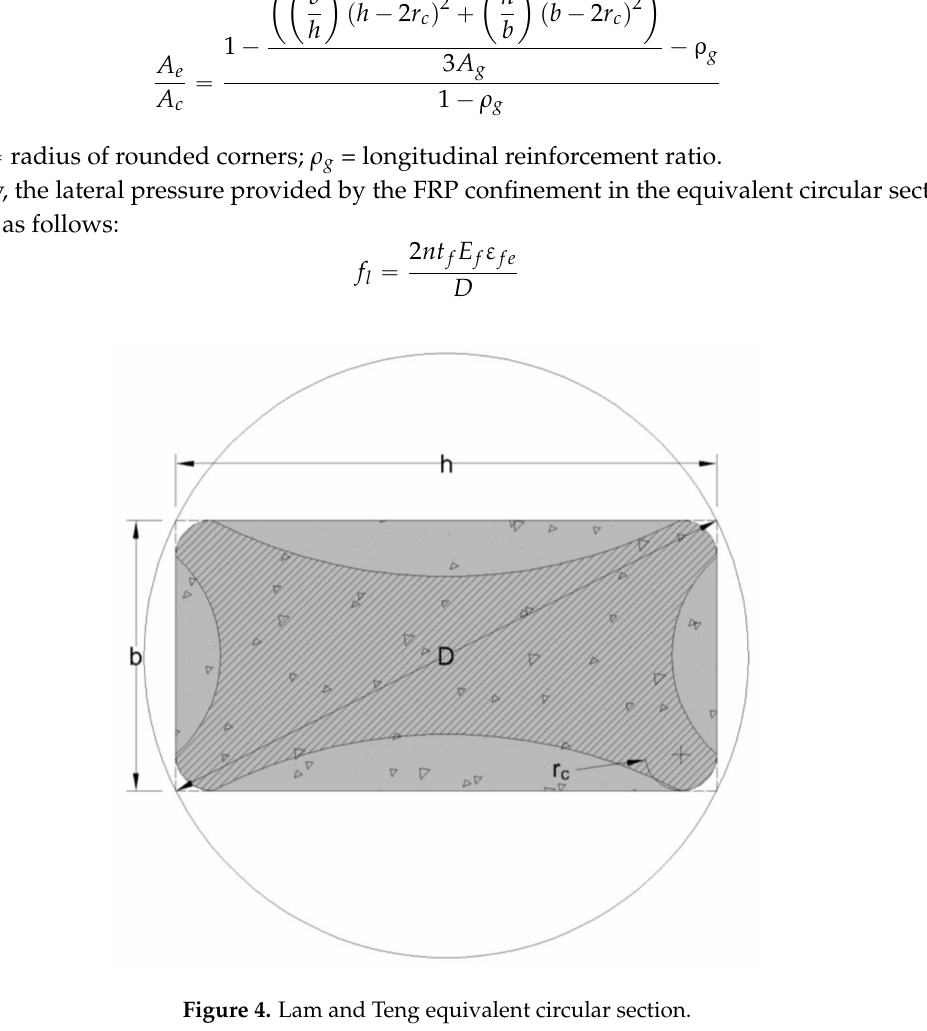
Figure 4. Lam and Teng equivalent circular